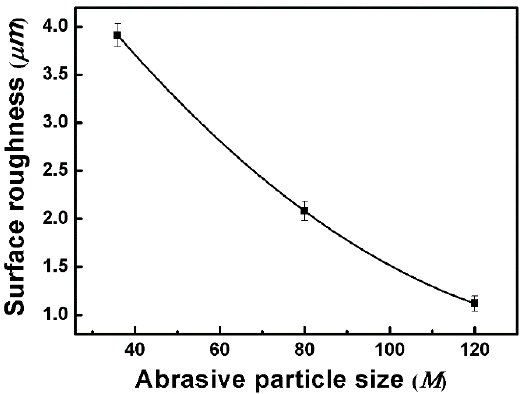
Figure 9. Surface roughness of treated specimens as a function of different abrasive particle sizes.